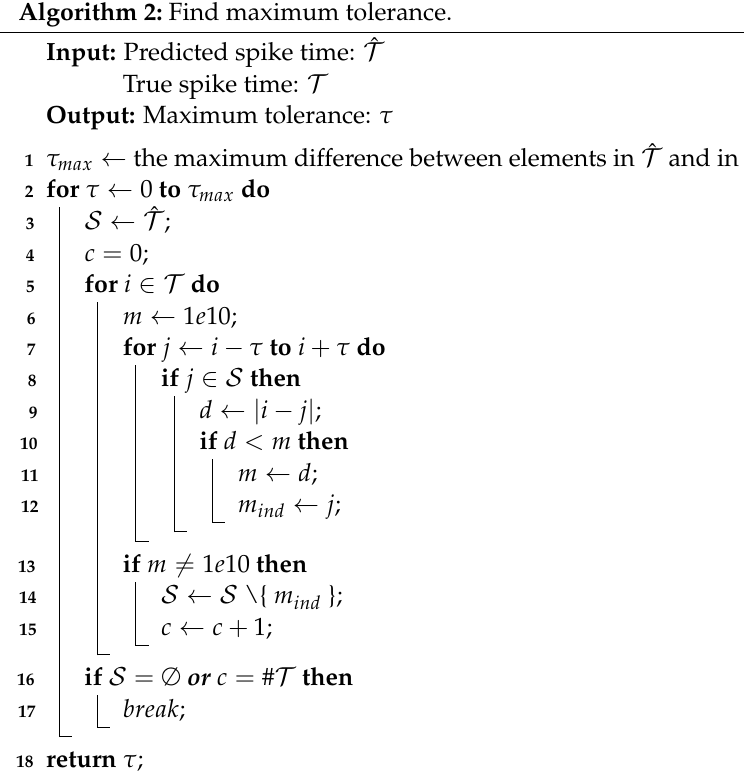
Algorithm 2: Find maximum tolerance.